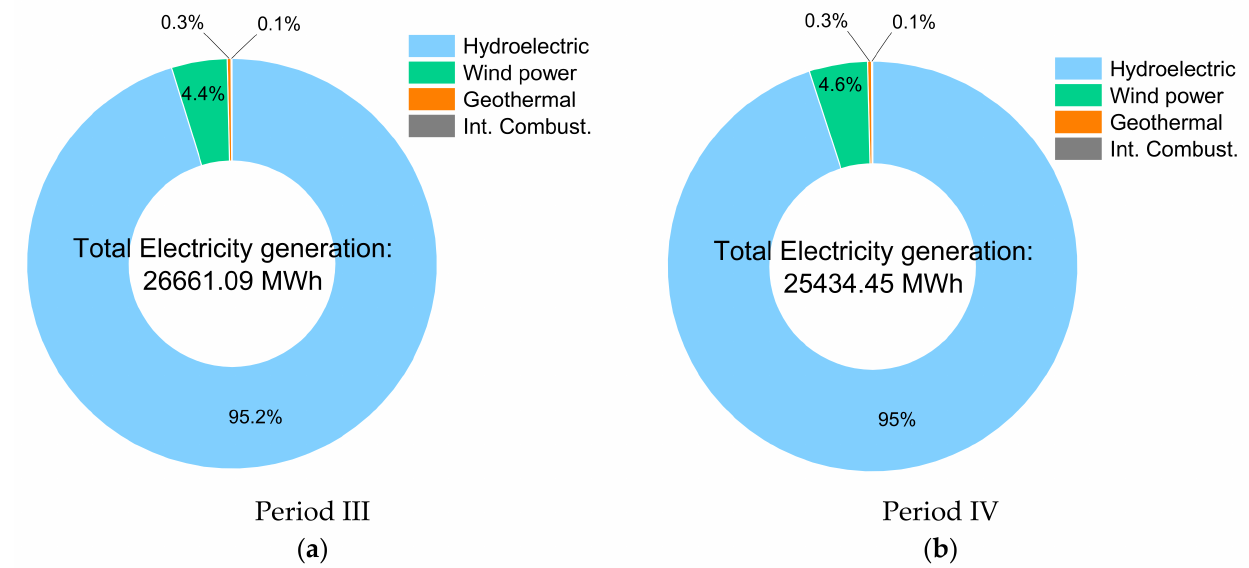
Figure 6. Generation and Energy in periods 3 and 4. ( a ) Period 3. ( b ) Period